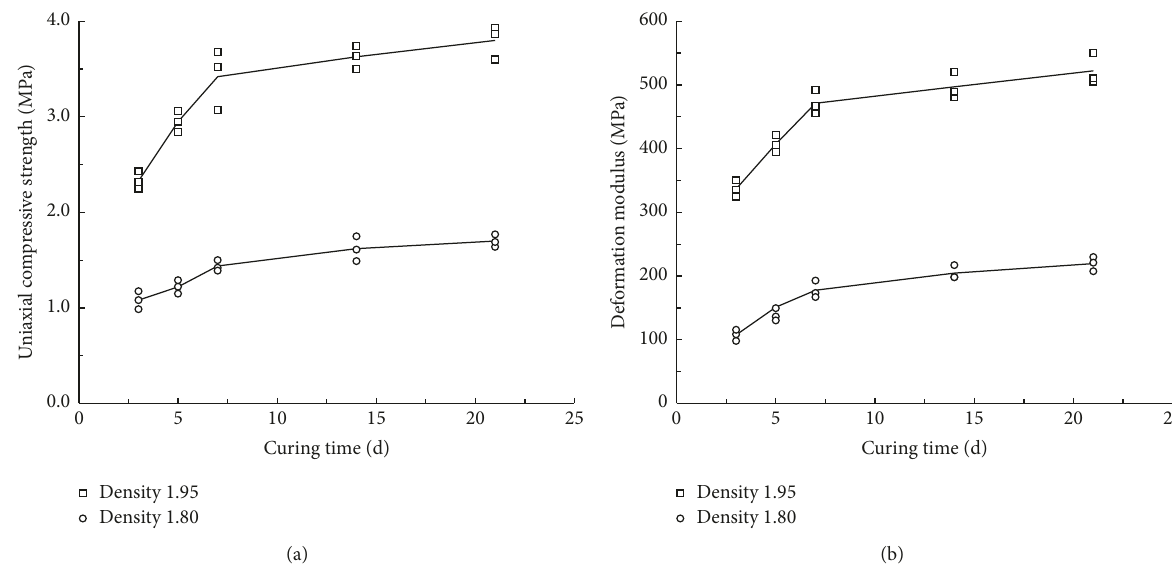
Figure 5: The variation of parameters against curing time: (a) uniaxial compressive strength; (b) deformation modulus.